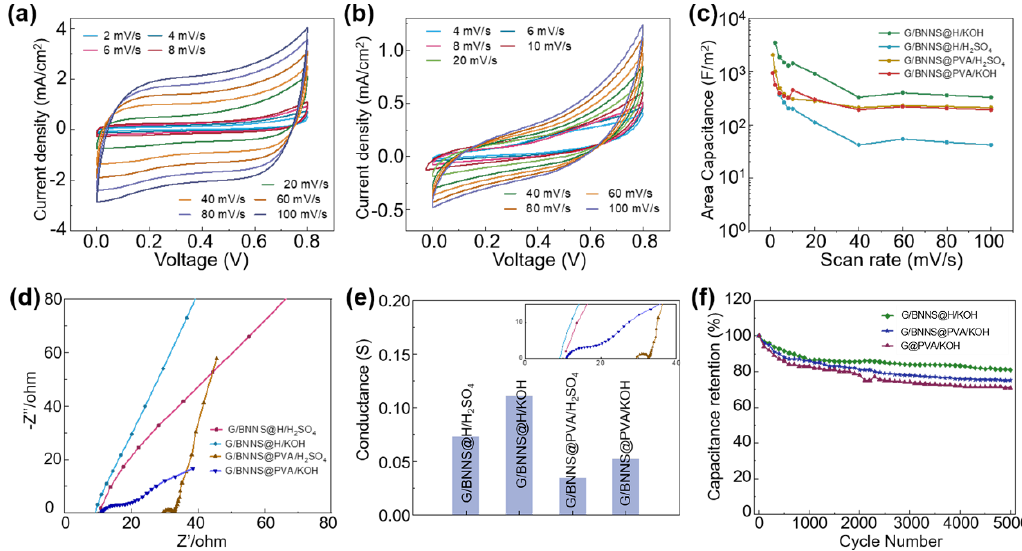
Figure 5. The electrochemical behavior of the WSCs. ( a ) CV curves of the WSC based on G/BNNS@H/KOH. ( b ) CV curves of the WSC based on G/BNNS@H/H 2 SO 4 . ( c ) Areal capacitance of WSCs at different scan rates. ( d ) Nyquist plot of WSCs. ( e ) The conductance of WSCs. ( f ) Cycling stability of WSCs at a current density of 0.53 mA/cm 2 .